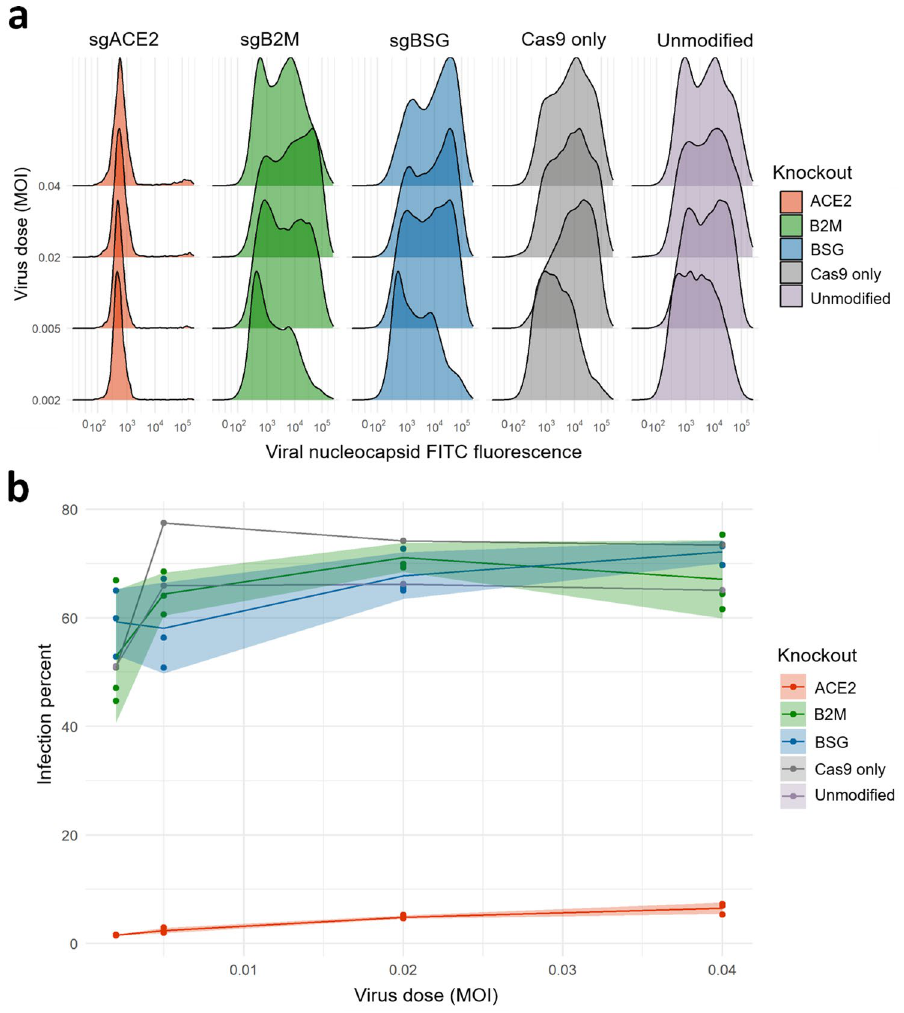
Figure 4. Knockdown of basigin by CRISPR-Cas9 in a lung cell line has no effect on susceptibility to SARS- CoV-2 infection. ( a ) Knockout of the known viral entry receptor ACE2 blocks viral infection in CaLu-3 cells, but not single guide (sgRNA) knockouts of basigin or negative control MHC class I receptors. Representative flow-cytometry profiles of SARS-CoV-2 nucleocapsid protein in CaLu-3 cells 48 h post-infection. ( b ) Lung cells with cell-surface basigin knocked down have no significant change in rates of viral entry and SARS-CoV-2 infection. Three replicates were performed of all 3 knockout conditions. Shading represents standard deviation from the mean percent of cells